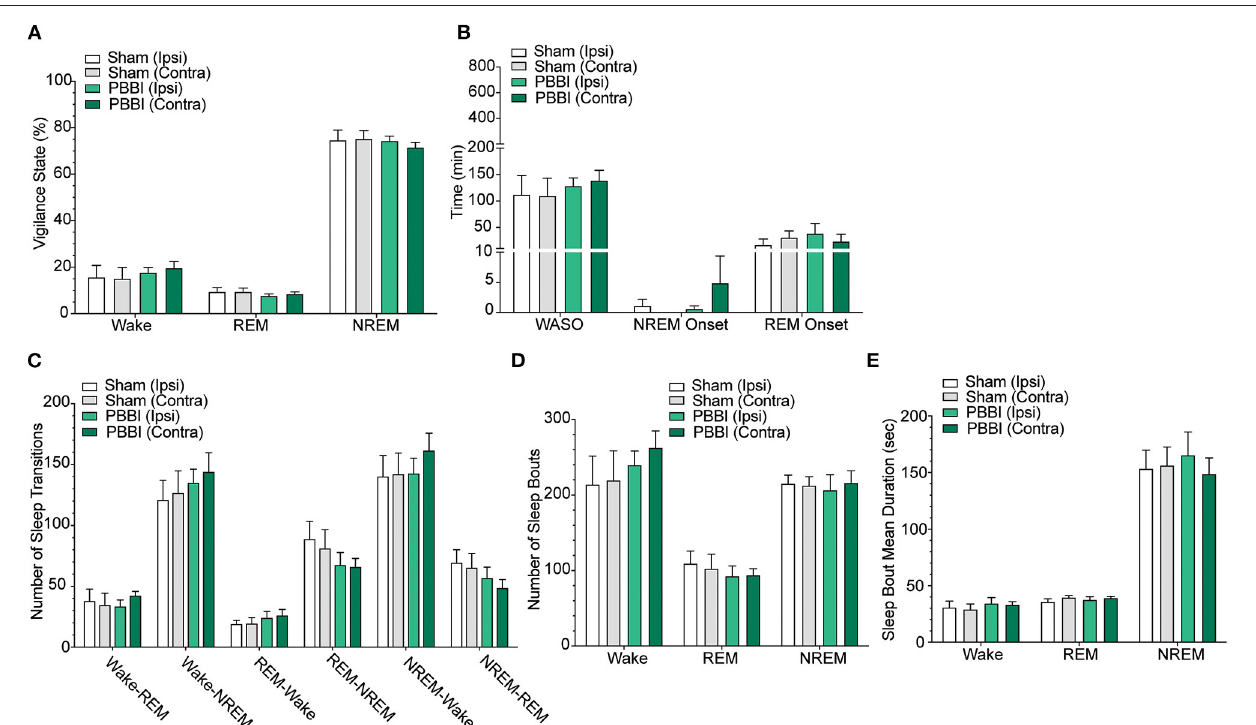
FIGURE 3 | Sleep parameters for contralateral and ipsilateral hemispheres in sham and PBBI animals in the light pre-injury baseline phase. Time spent in each vigilance state was collapsed over 12h bins during baseline recordings and compared between hemispheres and injury groups. There were no significant differences between hemisphere and injury groups across (A) vigilance states, (B) sleep parameters, (C) quantity of sleep stage transitions, (D) number of sleep stage bouts, (E) mean bout duration. Time spent in each vigilance state was collapsed over 12h bins and compared between hemispheres and injury groups. N = 6 PBBI / 5 sham. All data are depicted as the mean ± SEM. WASO = wake after sleep